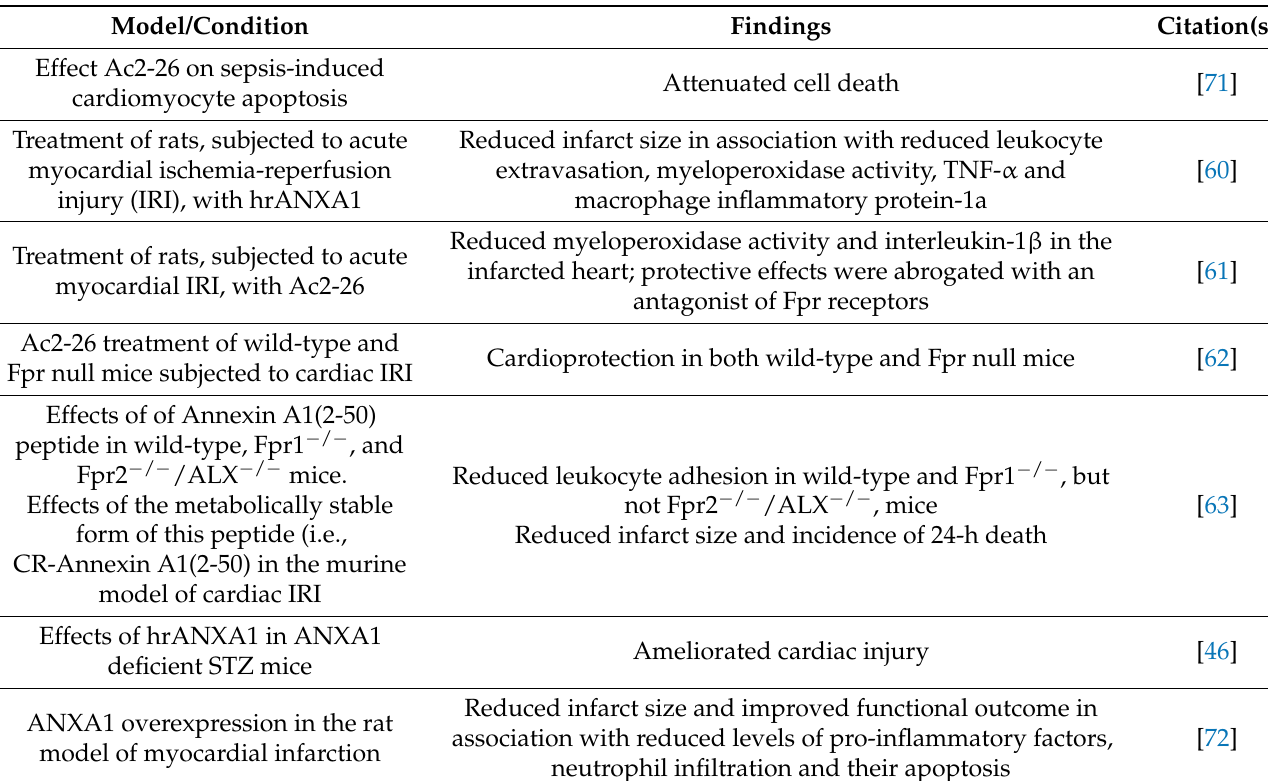
Table 3. Therapeutic potential of Annexin A1 modulation in cardiac injury models.